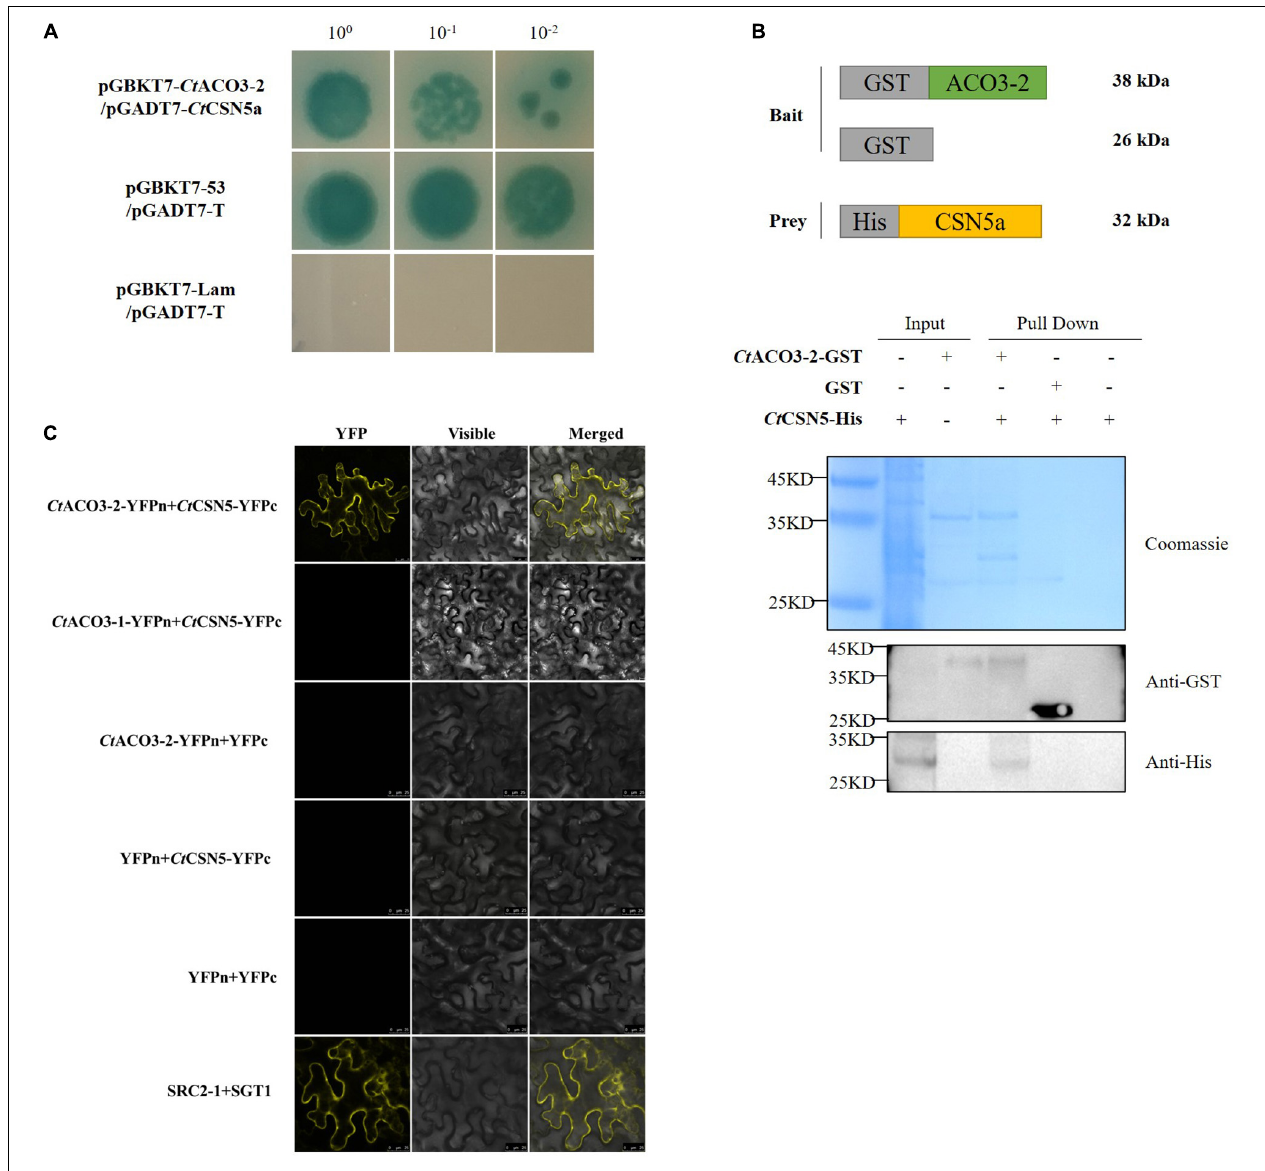
FIGURE 5 | Ct ACO3-2 interacts with the COP9 signalosome (CSN) subunit 5. (A) Yeast two-hybrid (Y2H) assay showing that Ct ACO3-2 interact with Ct CSN5a. (B) Glutathione S-transferase (GST)-pull down assay showing that Ct CSN5 associates with Ct ACO3-2 in vitro . Purified GST- Ct ACO3-2 or GST proteins were bound to glutathione-sepharose beads, and then incubated with His- Ct CSN5a. Here, we show the protein bands of resulting pull-down products after western blotting with anti-GST and anti-His antibodies. (C) Bifc assay showing that Ct CSN5 interact with Ct ACO3-2 but not Ct ACO3-1 in vivo